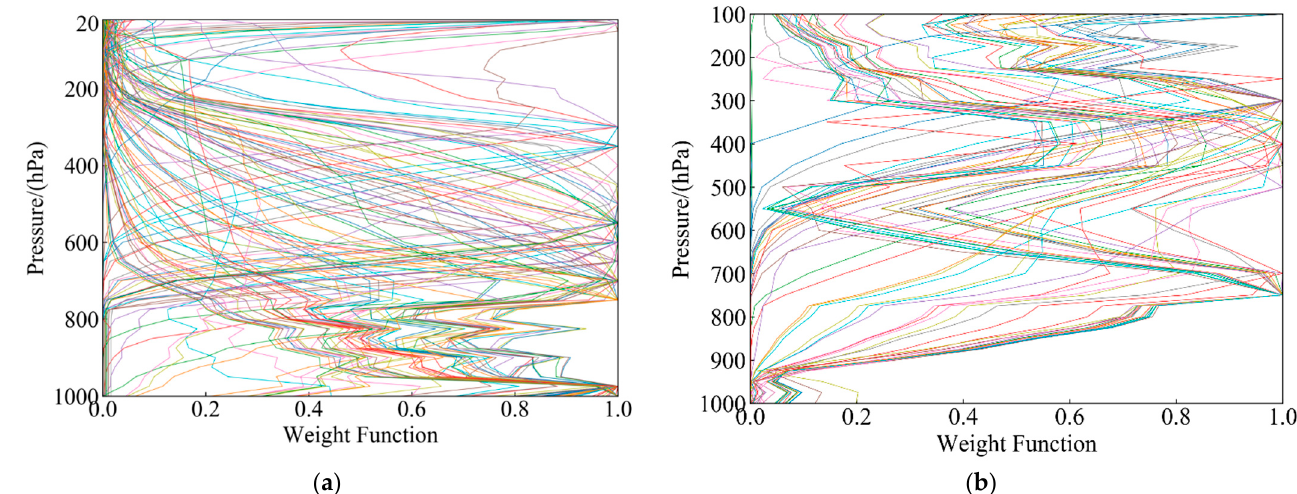
Figure 2. Normalized weight function. ( a ) Temperature; ( b ) humidity.